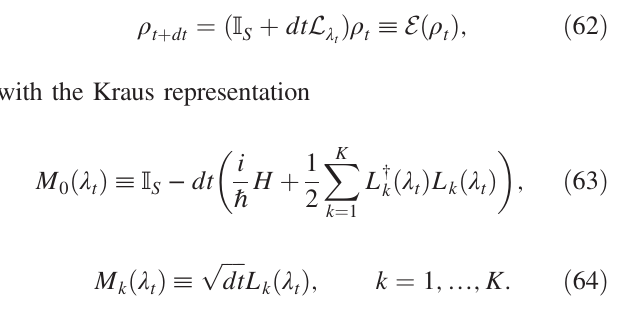
in the concatenation consists in the interaction of ν l ; l ˆ U ð l Þ Λ via the unitary . The ancilla is measured Λ depending on the protocol l E and μ , l l